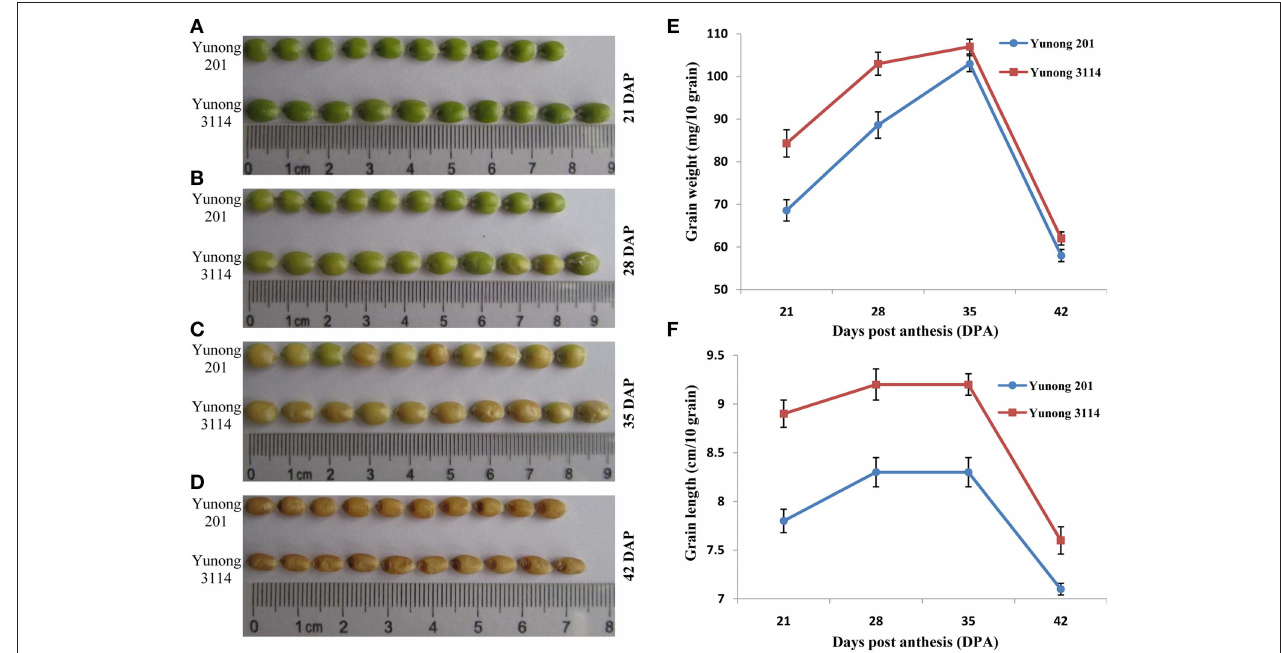
FIGURE 1 | Grain development during four grain developmental stages (21, 28, 35, 42) in Yunong 3114 and Yunong 201. (A–D) Grain morphological development; (E) Grain weight accumulation; (F) Grain length accumulation.